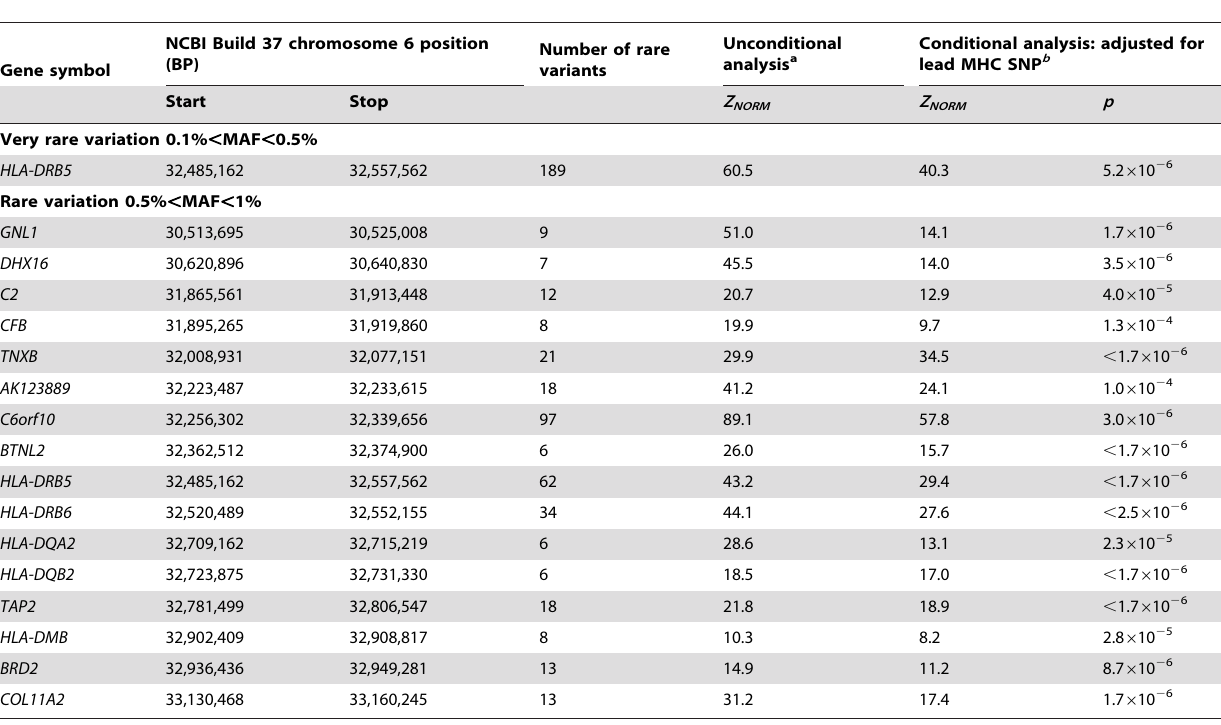
Table 2. Genes demonstrating genome-wide significant evidence of rare variant association with type-1 diabetes on chromosome